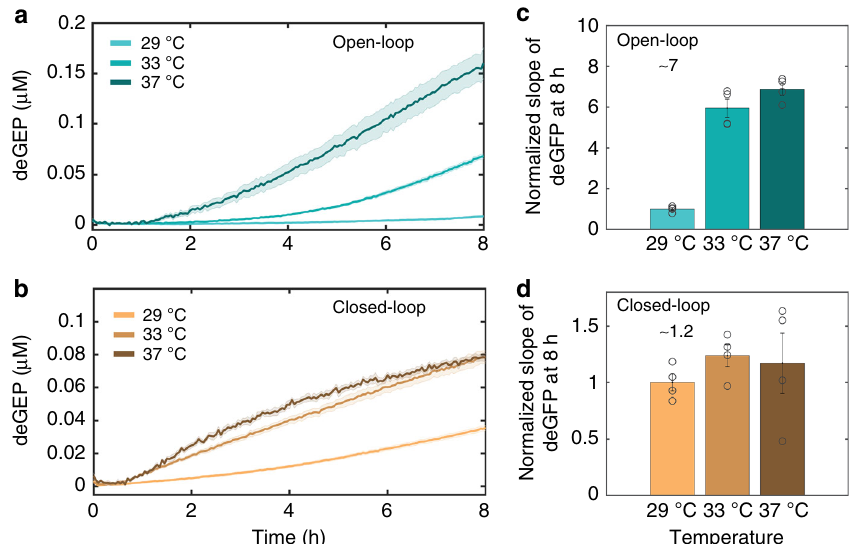
Fig. 6 Closed-loop controller enables robustness to the global perturbation. a , b Measured response of the controller at three different external constant change in the reaction temperatures for the a open-loop ( P tot YC and P tot Z were both 0.1 nM) and b closed-loop ( P tot Y and P tot Z were both 1 nM each) cases while initial P X was 0.1 nM. The error bars are shown in the shaded region and were determined using the standard error of the mean of three or more repeats. c , d Summary of the normalized deGFP slopes of the controller at 8 h for the c open-loop and d closed-loop operations. Error bars are from the SEM of at least three repeats. To disable the feedback in the open-loop case, P tot Y was replaced by P tot YC , which expresses a protein that cannot sequester with X . The responses shown in c , d were normalized with respect to the deGFP slope value recorded at 29 °C. Plate readers were calibrated at 29 °C, 33 °C, and 37 °C separately to a standard curve of GFP to ensure fl uorescence variation re fl ects protein concentration variation (see Supplementary Fig. 24). Before calculating deGFP slopes, measured deGFP responses were smoothed-out using the rloess smoothing method in MATLAB. Source data are provided as a Source Data fi